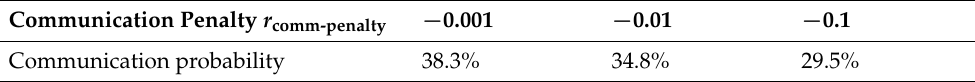
Table 5. Communication cost and the communication probability in Habitat 3-ON. Communication Penalty r